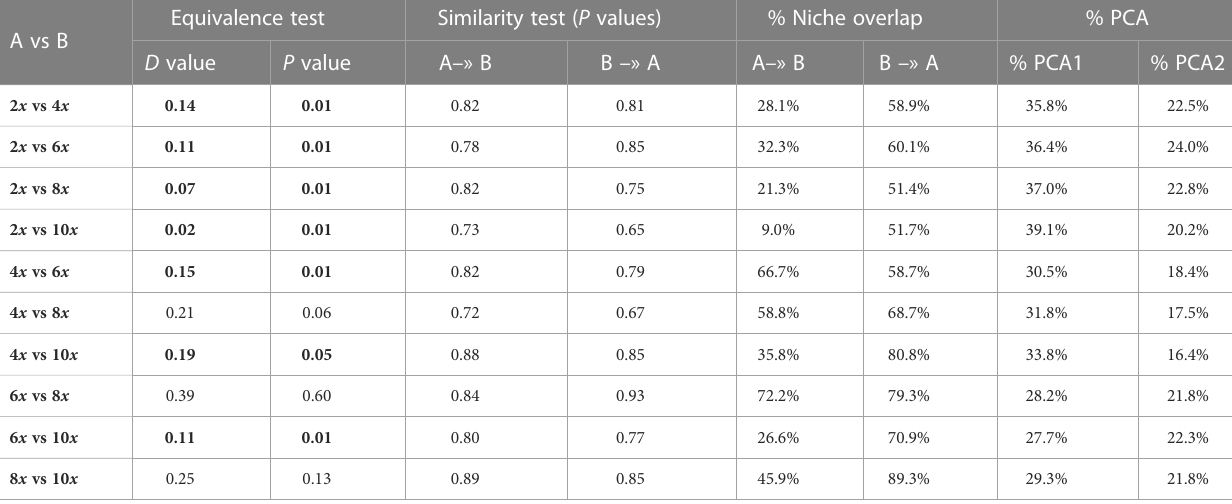
TABLE 3 Equivalency ( D and P values) and similarity ( P value) tests for suitable habitat for each pair of cytotypes of L. suffruticosum s.l.